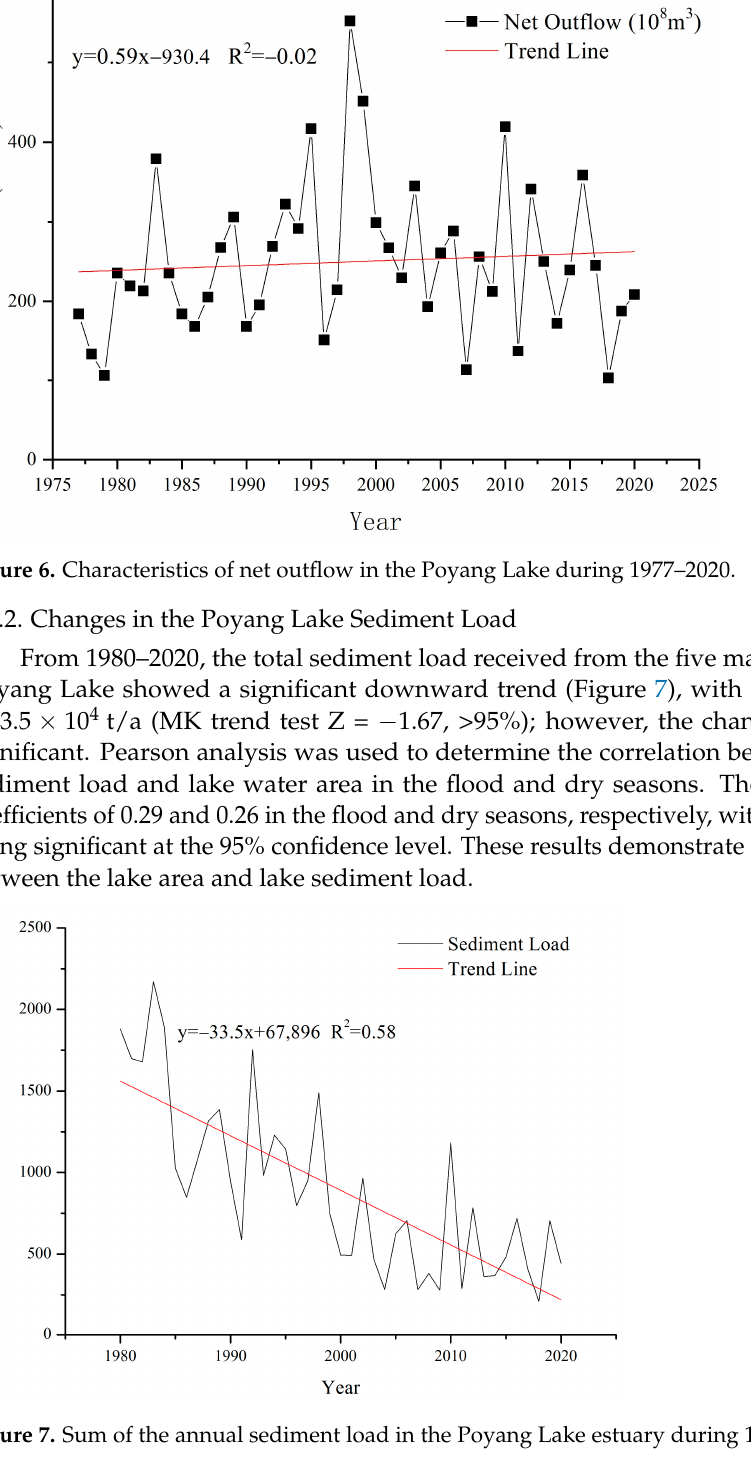
Figure 5. Characteristics of inflow in Poyang Lake during 1977–2020.